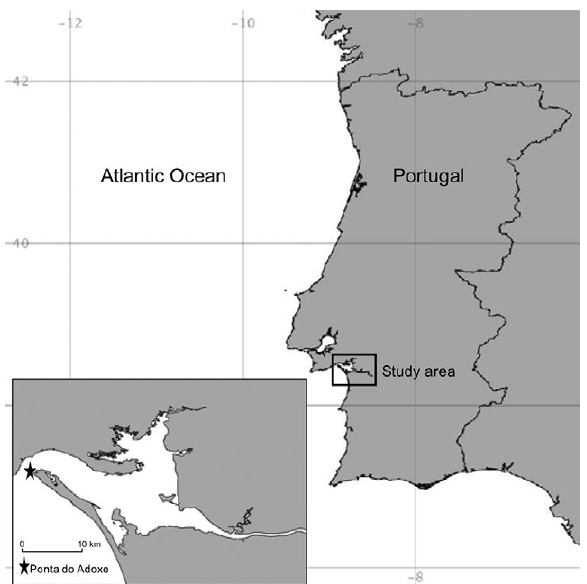
Fig. 1. – Map of Portugal showing the region studied. Troia penin- sula with a star indicating the study site in Ponta do Adoxe, followed before and after disturbance of a Zostera marina